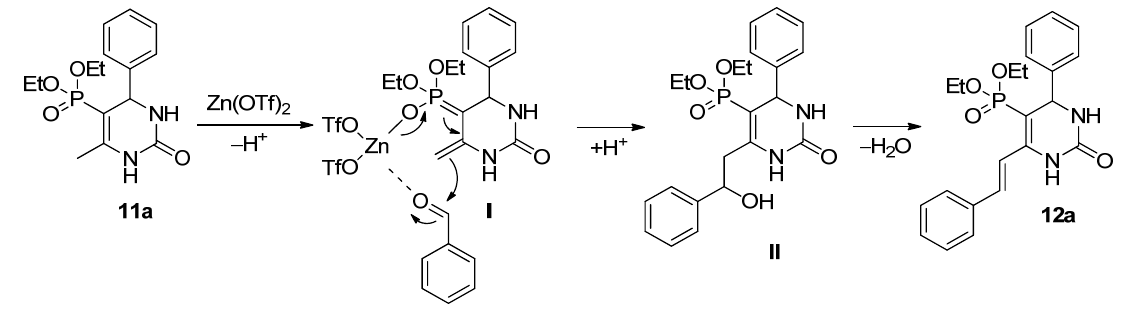
Scheme 3. Proposed mechanism of the formation of compound 12a